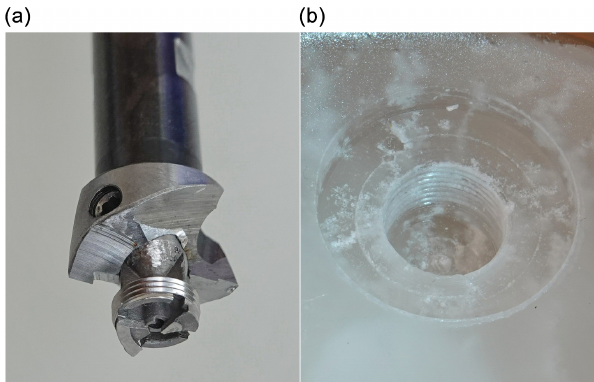
Figure 7. RADIX 20mm Forstner drill bit with an inserted 10mm thread-cutting center bit (a) . Test drilling in paraffin wax (b)